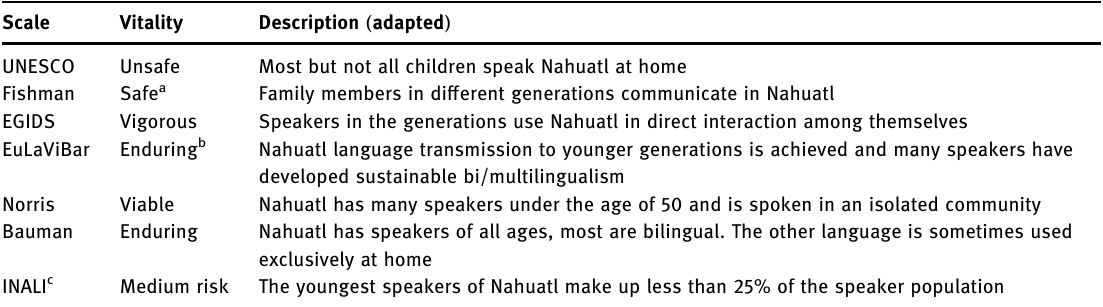
Table 7: Nahuatl language vitality in Tlaxco ( by home language/intergenerational language transmission )